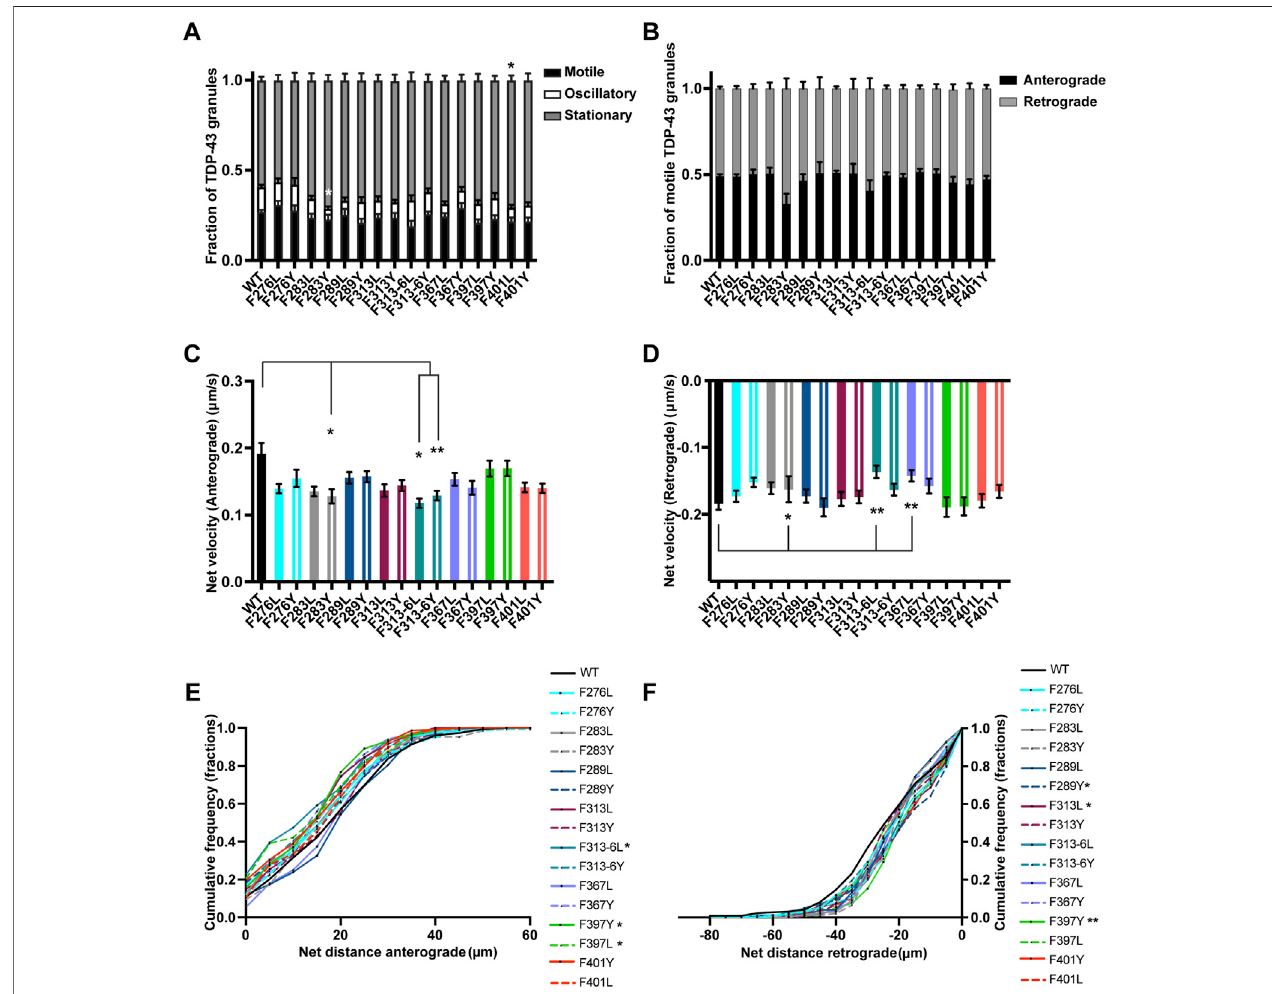
FIGURE8| TDP-43mutationdisruptingFinLARKSaffectsRNPtransport. (A) WTTDP-43orTDP-43LCDFmutantkymographsfrom3independentexperiments are analyzed to determine the motility of different RNP granules. Fraction of motile, oscillatory and stationary RNP granules are plotted. (B) The fraction of motile RNP granules for WT TDP-43 and each of the TDP-43 LCD F mutant (shown as black bars in Figure 8A ), are further categorized as granules travelling in retrograde or anterograde direction and the resulting fraction isplotted. (C) The anterogradenet velocity ( μ m/s) for each of the motile WT TDP-43 or TDP-43LCD F mutant RNP granule was determined using custom semi-automated analysis in MATLAB and the average net velocity is plotted (N = 3, WT n = 104, F276L n = 105, F276Y n = 98, F283L n =88,F283Y n =49,F289L n =72, F289Y n =71,F313L n =85,F313Y n =101,F313-6L n =43,F313-6Y n =124,F367L n =86,F367Y n =95,F397L n =75, F397Y n =84,F401L n =71,F401Y n =91,from9to15neuronspercondition). (D) Theretrogradenetvelocity( μ m/s)foreachofthemotileWTTDP-43orTDP-43LCDF mutant RNP granule was determined using custom semi-automated analysis in MATLAB and the average net velocity is plotted (N = 3, WT n = 128, F276L n = 109, F276Y n =125,F283L n =95,F283Y n =75,F289L n =79,F289Y n =70,F313L n =82,F313Y n =100,F313-6L n =59,F313-6Y n =124,F367L n =92,F367Y n =90, F397L n = 73, F397Y n = 100, F401L n = 88, F401Y n = 99). Error bars represent standard error mean. (E) Anterograde or (F) retrograde net distance cumulative frequencydistribution forTDP-43WTorLCDFmutantRNPgranules, from3independentexperiments. OnewayANOVA(Kruskal – WallistestwithDunn ’ scorrectionfor multiple comparisons) was used to determine statistically signi fi cant difference among different samples. * p < 0.05, ** p < 0.01.